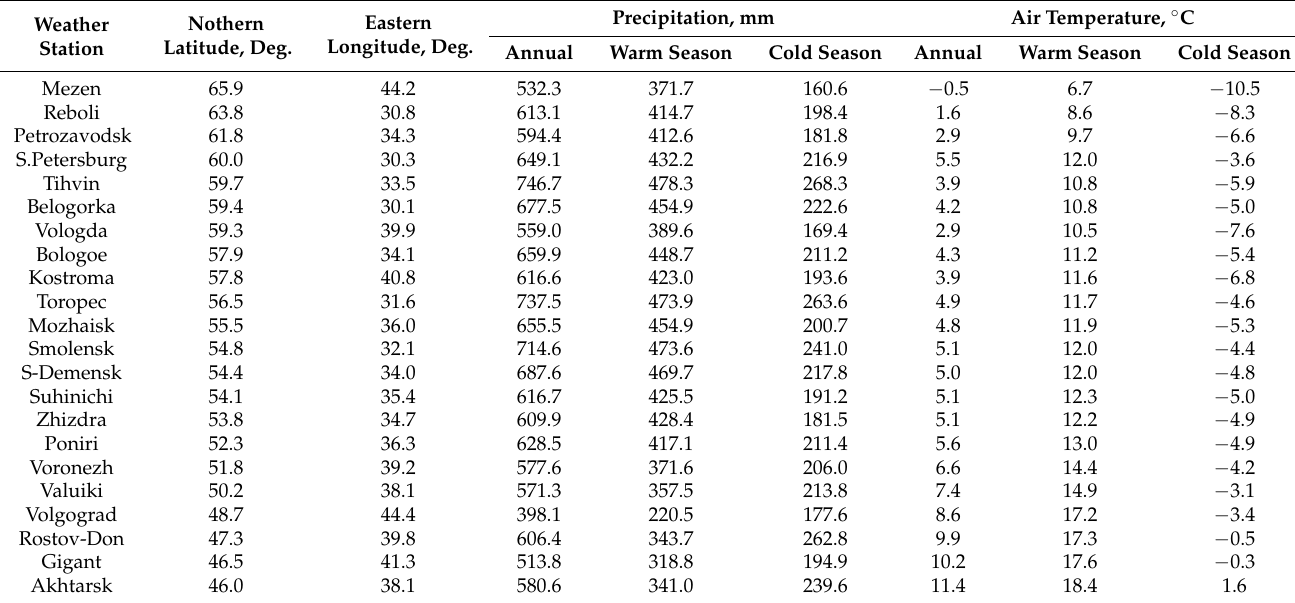
Table 1. Average long-term values of annual, warm season (April-October) and cold season (November-March) precipitation and air temperature for the period 1965-2018 according to ER weather stations. Eastern Nothern Weather Longitude, Latitude, Deg. Station